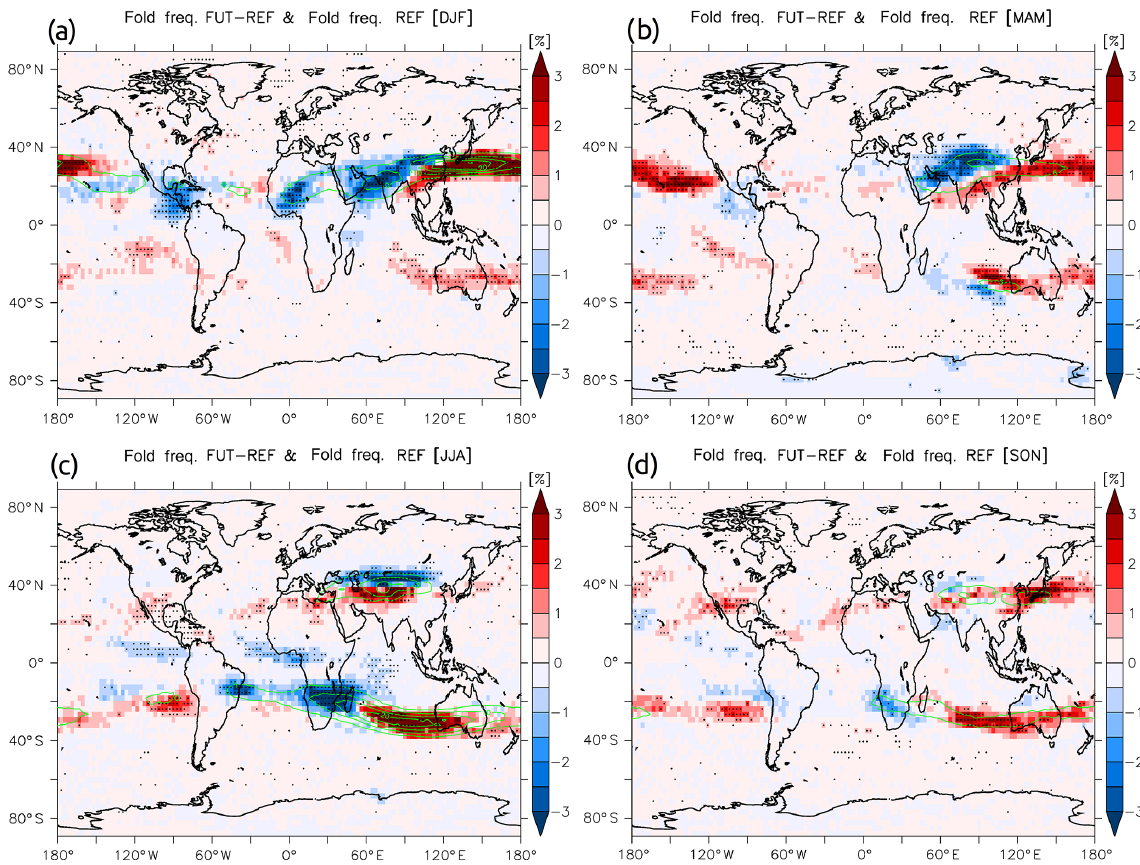
Figure 4. Mean tropopause fold frequency differences (shaded; %) between the FUT and REF periods for DJF (a) , MAM (b) , JJA (c) , and SON (d) . The green contours denote the tropopause fold frequency (%) during the REF period. The regions where the changes are statistically significant at the 99% confidence level are hatched with black